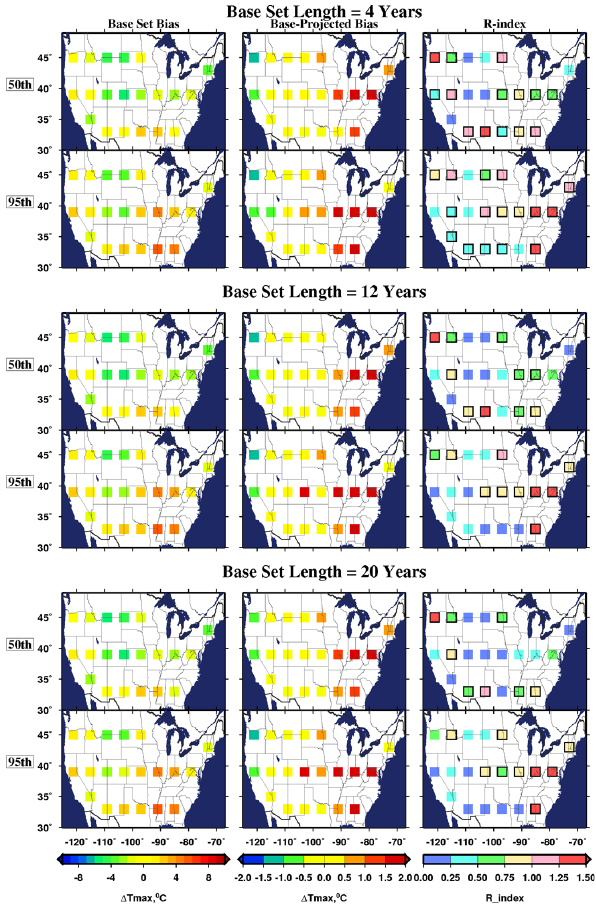
Fig. 3. Mean bias (of 100 Monte Carlo simulations) in daily JJA Tmax for the GFDL model output for three different base set sizes (left panels), the mean difference in bias between the base and pro- jected sets (center panels), and the mean R index value (right pan- els). Grid cells with dark outlines indicate where R values are not consistently less than 1 at 95% confidence. Projected set size is